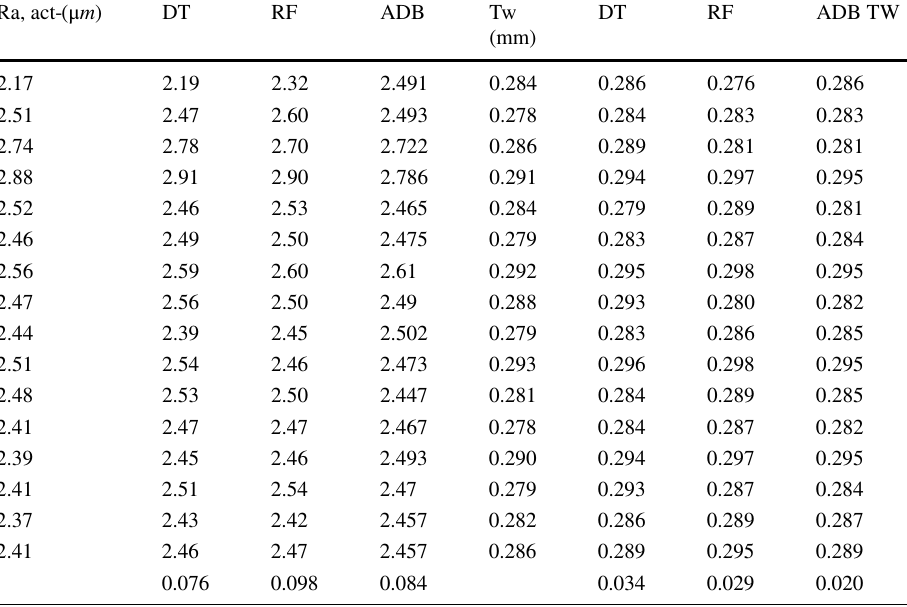
Table 14 Predicted values by machine learning methods (DT,RF and Ada Boost